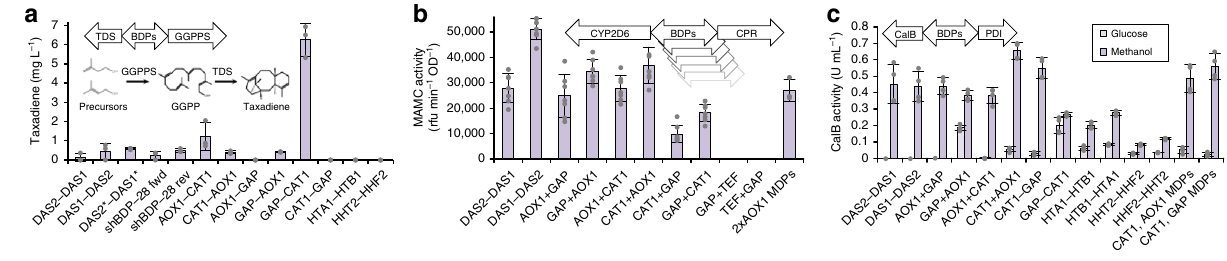
Fig. 6 Applying the library of BDPs helps to fi nd the optimal expression condition for dual gene co-expression. For each of the three pair of genes tested, a different BDP performed best and the activity/yields for the same set of genes spanned a 5.2 – 50-fold range. a Highest taxadiene yields were achieved using a P GAP-CAT1 fusion promoter for GGPPS and TDS co-expression. The designs based on different BDPs span a 50-fold range in yields. DAS2*-DAS1* denotes the improved promoter variant DAS2-d8-DAS1-d2d5 (Fig. 3c, Supplementary Fig. 2). Constitutive expression of the GGPPS gene was detrimental. Yields determined by GC-MS from shake fl ask cultivations (biological triplicates, mean value, and standard deviation shown) with a dodecane overlay. b Highest activity for the co-expression of human CYP2D6 and its associated CPR was achieved using the natural P DAS1-DAS2 promoter in reverse orientation. The designs based on different BDPs span a 5.2-fold activity range. “ 2× AOX1 MDPs ” indicates a control strain expressing the two genes using two monodirectional AOX1 promoters. The strains were pre-grown for 60 h on glucose and induced with methanol for 72 h. Activity of biological seven-fold replicates (mean value and standard deviation shown) was measured by a whole-cell bioconversion assay using 7-methoxy-4-(aminomethyl)-coumarin (MAMC) as substrate. c Bidirectional fusion promoters of P CAT1 to P AOX1 or P GAP give the highest volumetric activities in the co-expression of secreted CalB and the chaperone PDI. The designs based on different BDPs span a 22-fold activity range. “ CAT1, AOX1 , MDPs ” and “ CAT1, GAP and MDPs ” are control strains mimicking the best bidirectional designs with MDPs. Activities in the supernatant of biological quadruplicates (mean value and standard deviation shown) were measured after growth for 60 h on glucose and methanol induction for 72 h using a p-nitrophenyl butyrate (pNPB)